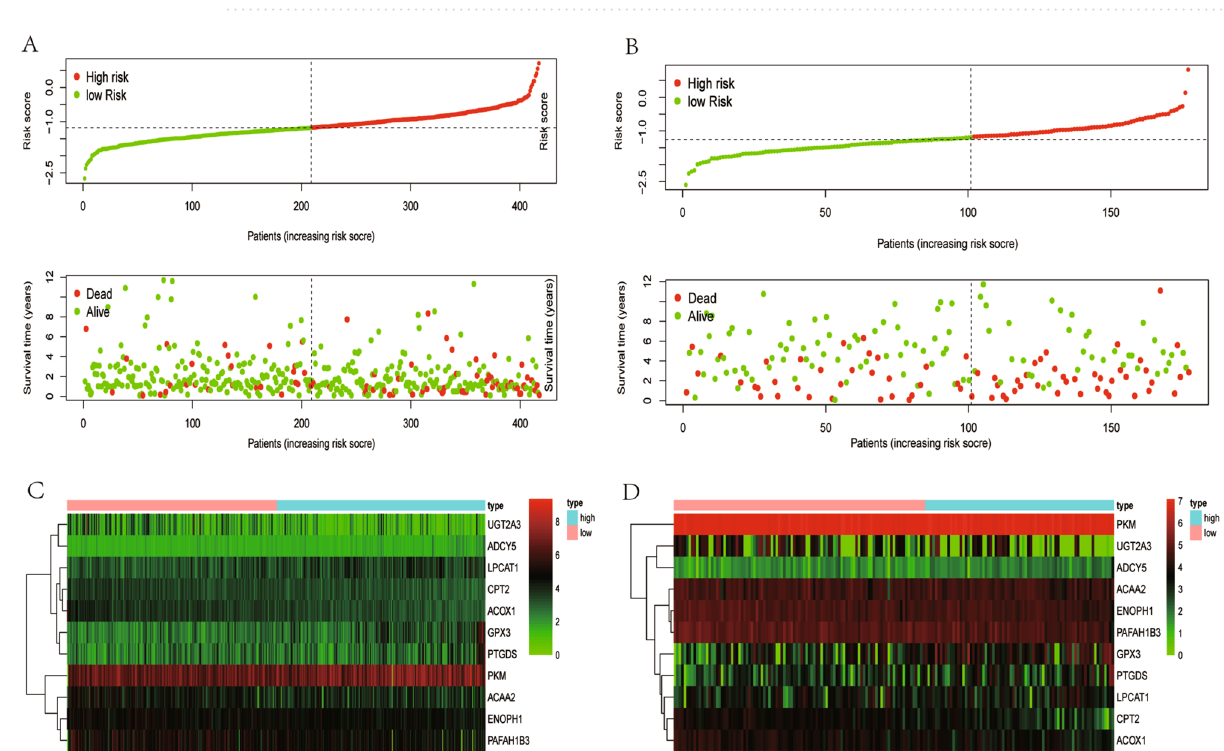
Figure 4. Risk scores of Metabolic Signature. ( A ) Risk score distribution of the eleven -gene signatures based on TCGA database. ( B ) Risk score distribution of the eleven-gene signatures based on GEO database. ( C ) Heatmaps of the differential expression of metabolic genes in high-risk and low-risk groups based on TCGA database. ( D ) Heatmaps of the differential expression of metabolic genes in high-risk and low-risk groups based on GEO